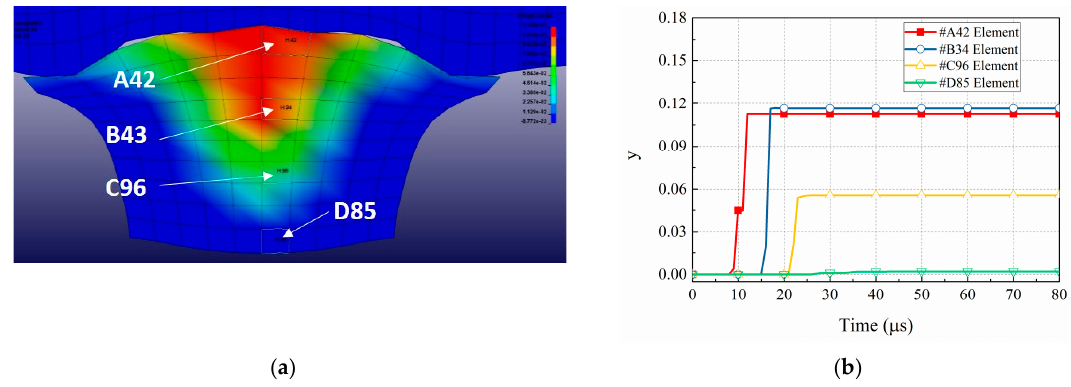
Figure 15. Time-history curve of the extent of the chemical reaction for three units of the Ai/Ni-based